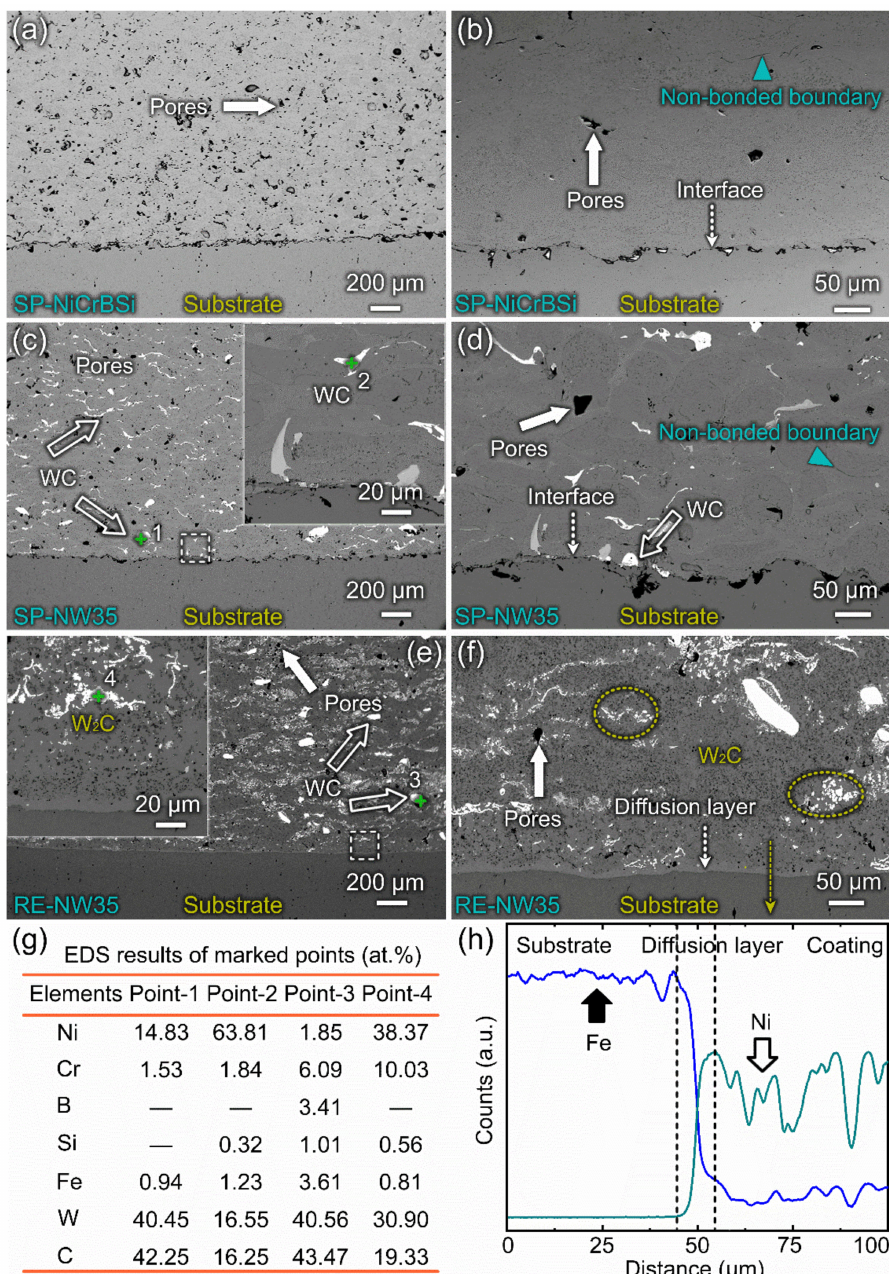
Figure 2. SEM observations for the cross-sectional morphologies of ( a , b ) SP-NiCrBSi, ( c , d ) SP-NW35, ( e , f ) RE-NW35, ( g ) EDS results of marked points in ( c ) and ( f ), and ( h ) the line scanning profiles of Ni and Fe elements at the interface of the RE-NW35 as marked by yellow arrow in ( f ). The insets are the enlarged views of dash rectangles in ( c ) and ( e